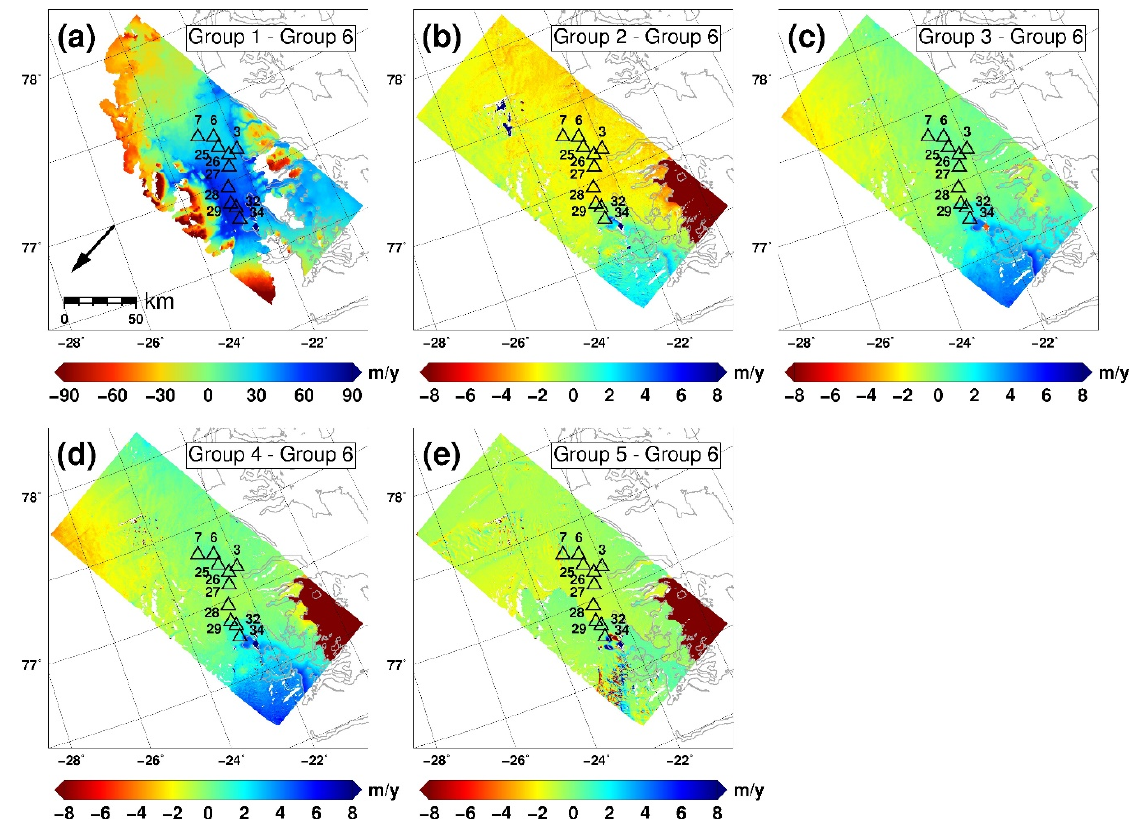
Figure 5. LoS velocity differences between groups 1 to 5 ( a – e ) with respect to group 6.